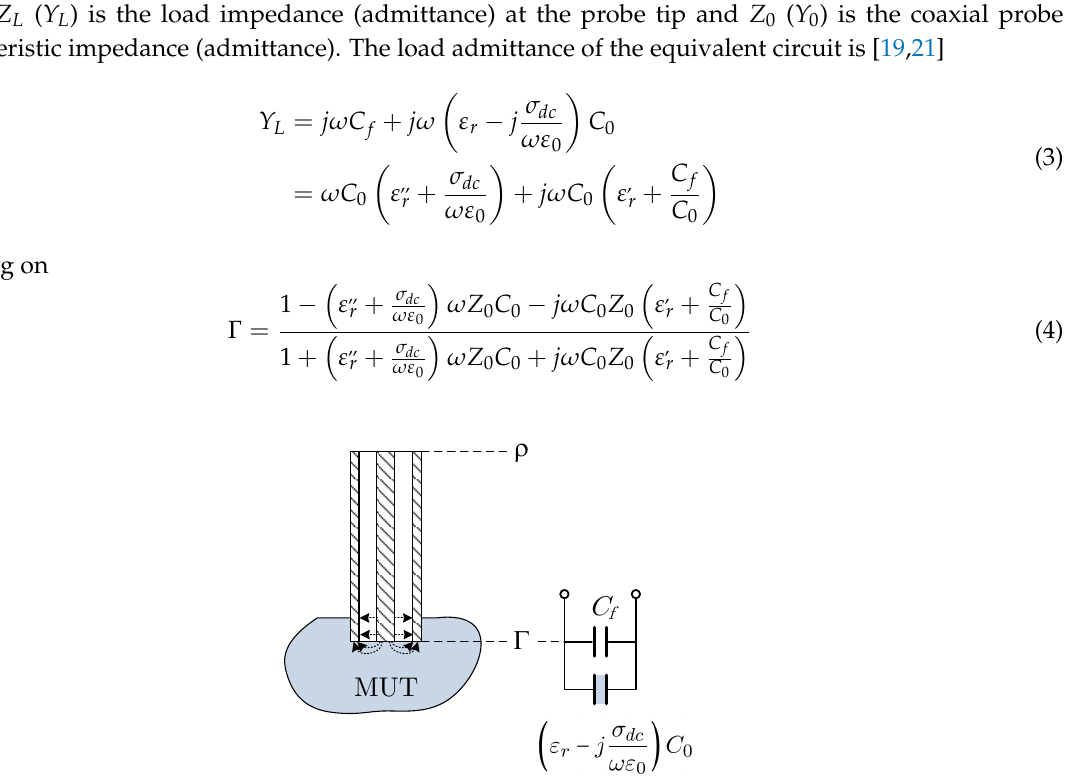
Figure 3. Equivalent circuit at the coaxial-MUT interface [21], where ε r = ε , r − j ε ,, r , C f is the fringing capacity at the tip of the probe, C 0 is the probe terminal capacity when in free space and ρ is the voltage reflection coefficient measured at the side of the probe connected to the vector network